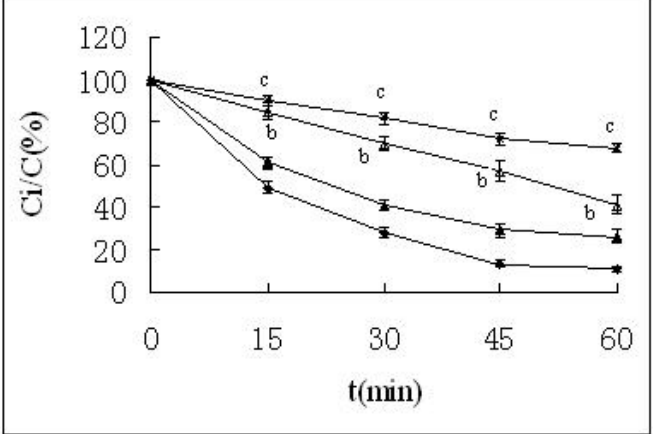
Figure 3. Percentage of the remained insulin against trypsin at 37 ºC. ■ — ■ Insulin + trypsin; ▲ - ▲ Insulin + HP- β -CD + trypsin; Δ — Δ Insulin + protamine + trypsin; *-* Insulin +protamine + HP- β -CD + trypsin. n=3, mean ± SD. b p < 0.05, c p < 0.01 vs insulin + trypsin solution according to paired t-test.